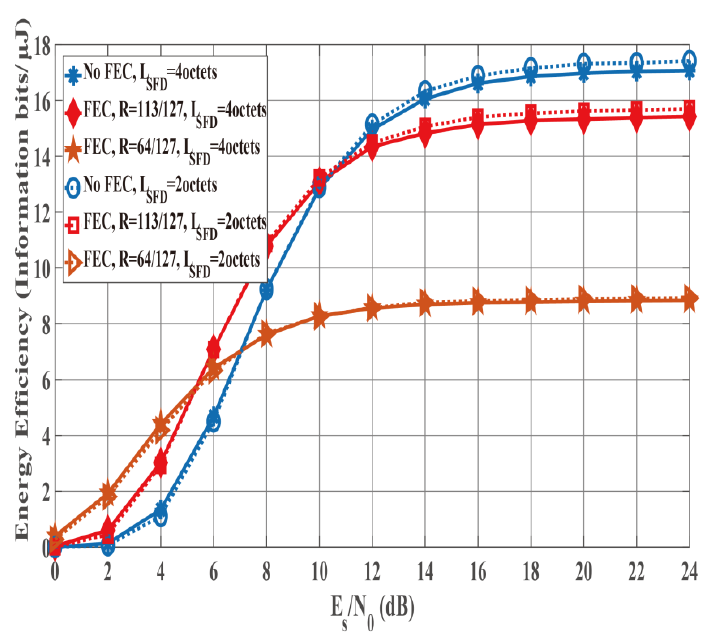
Figure 15. Energy efficiency performance as a function of 𝐸 𝑠 /𝑁 0 ( 𝐾 factor = 4.5). Case with an SFD ( 𝐿 𝑆𝐹𝐷 = 2 octets and 4 octets). ( L SFD = 2 octets and 4 octets).